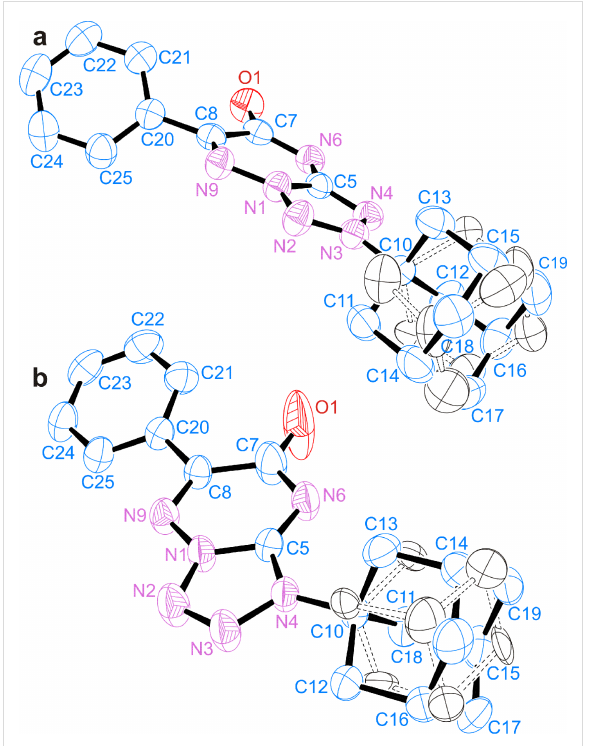
Figure 5: ORTEP diagrams of the X-ray structures of compounds 15a- 15 N 2 (a) and 15b- 15 N 2 (b). For clarity, the H atoms are omitted. The observed disorder of the adamantane fragment is shown by black ellipsoids and dashed bonds (the carbon atoms are unlabelled).